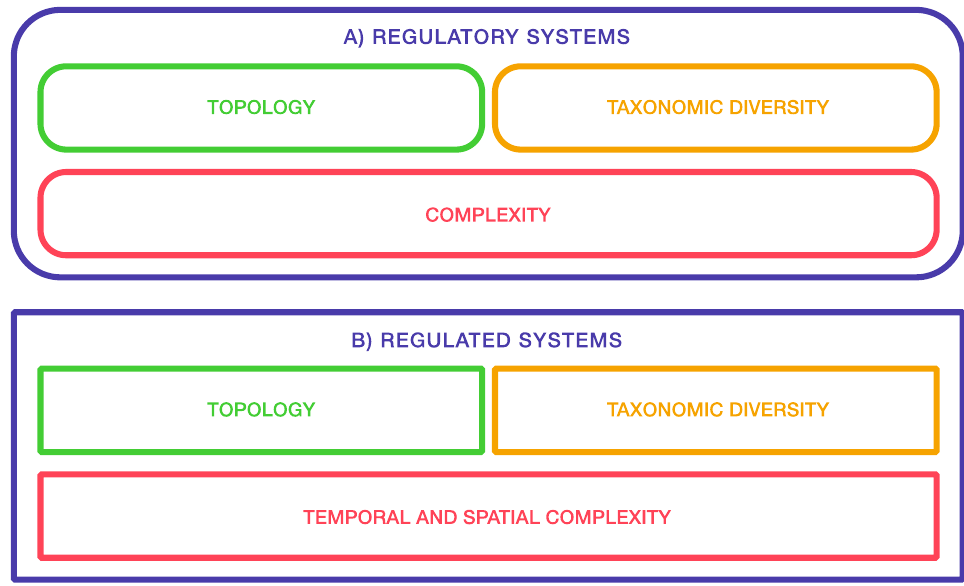
Figure 1. Both regulatory systems ( A ) and regulated systems ( B ) are complex and diverse. However, to assume a precise matching among them is unwarranted. To examine the extent and the topology of this mapping, we must first develop independent pictures of the structural and functional properties of GRNs on one side and those of organisms on the other side.